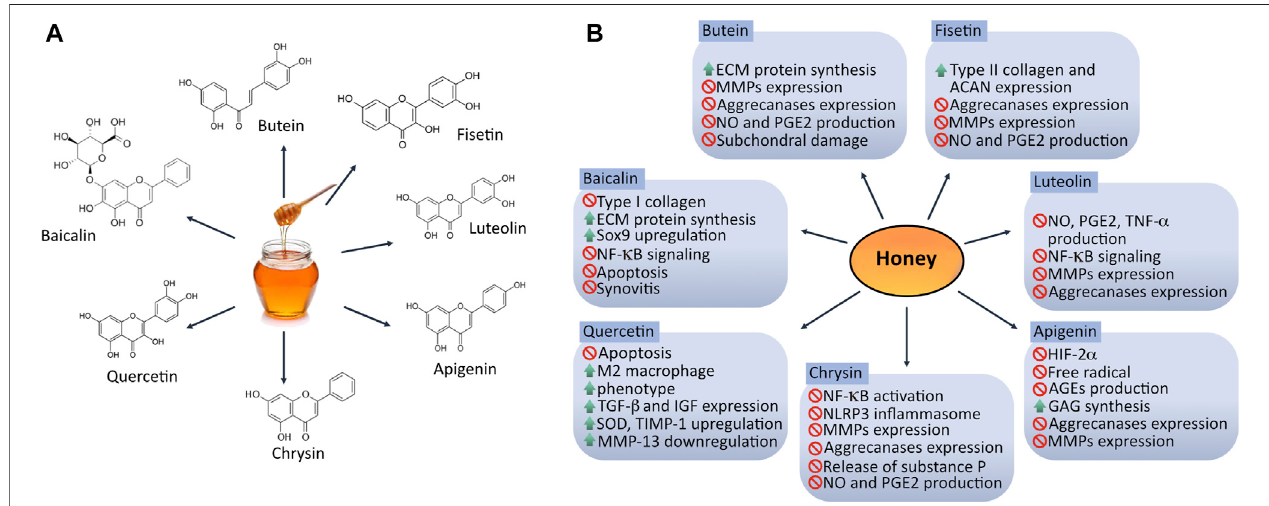
FIGURE 2 | Chondroprotective effect of bioactive compounds found in honey. (A) Structure of honey bioactive molecules with potential application in targeting dysregulation of articular homeostasis. (B) Mechanisms exerted by honey-derived fl avonoids in osteoarthritic joint. Different fl avonoids found in honey can modulate catabolism in joint tissues via several signaling pathways promoting chondrogenesis-related genes expression such as SOX9, ACAN and COL2A1. ACAN: aggrecan; AGEs: advanced glycation end-products; ECM: extracellular matrix; GAG: glycosaminoglycans; HIF-2 α : hypoxia-inducible factor 2 alpha; MMPs: metalloproteinases; NO: nitric oxide; PGE2: prostaglandin E2; SOD: superoxide dismutase. ↑ (cid:1) up-regulate/stimulate/increase; ∅ (cid:1) down-regulate/inhibit/suppress/